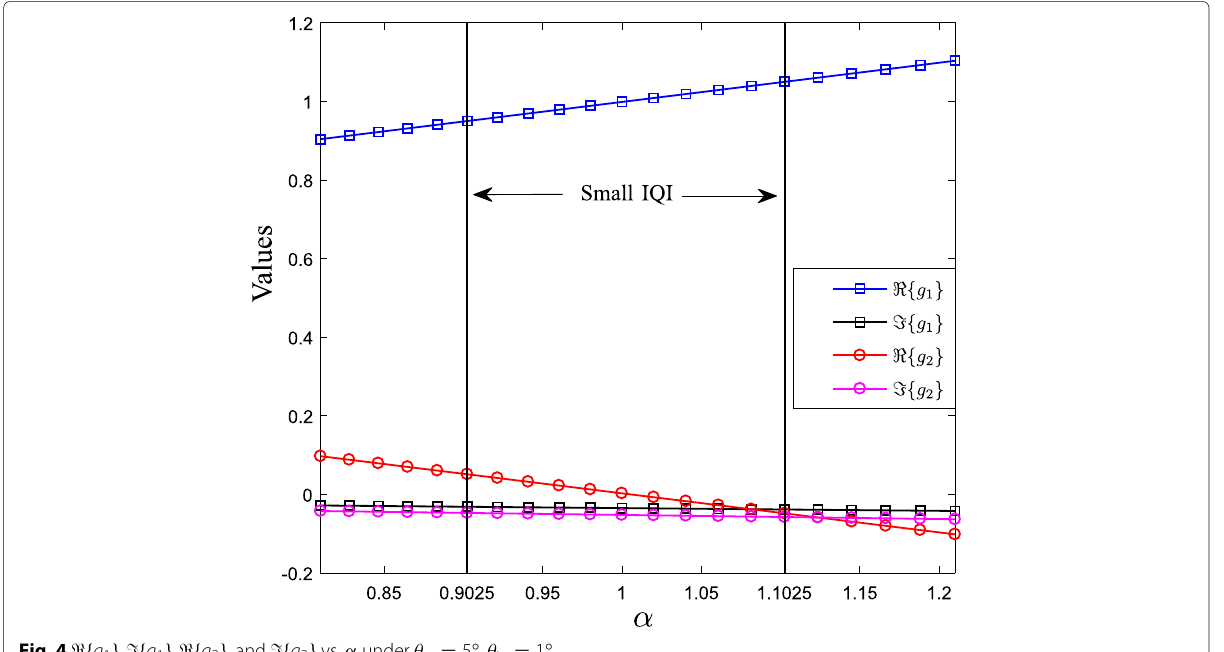
Fig. 4 (cid:3){ g 1 } , (cid:4){ g 1 } , (cid:3){ g 2 } , and (cid:4){ g 2 } vs. α under θ rx = 5 ◦ , θ tx = 1 ◦